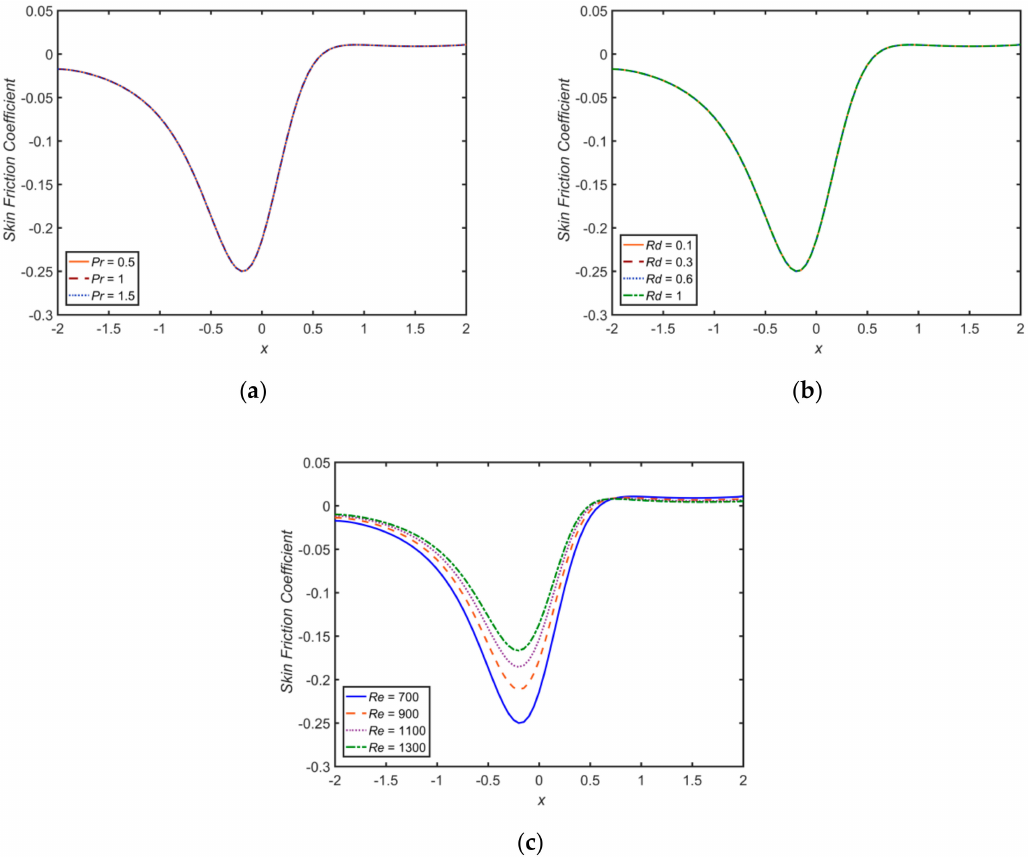
Figure 19. Skin friction profiles for ( a ) Pr = 0.5, 1, and 1.5; ( b ) Rd = 0.1, 0.3, 0.6, and 1; and ( c ) Re = 700, 900, 1100, and 1300; with M = 5 and St = 0.02, at t = 0.25.